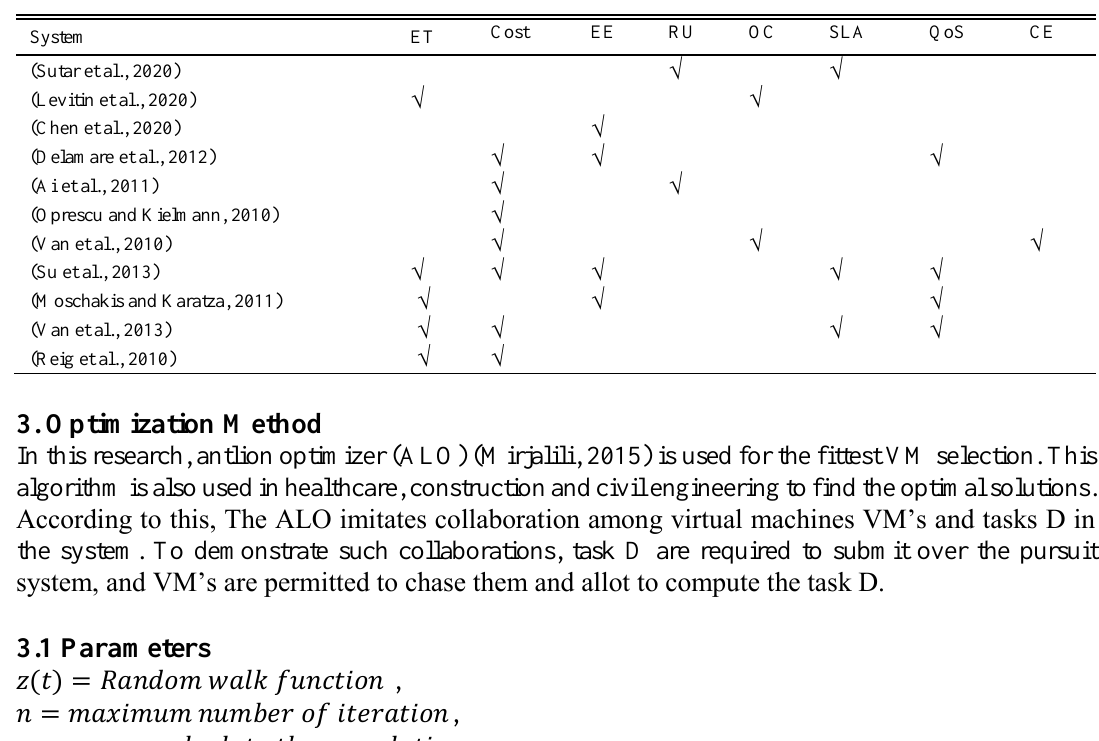
Table 1. Comparative analysis of SLA, Cost and Time-based resource management